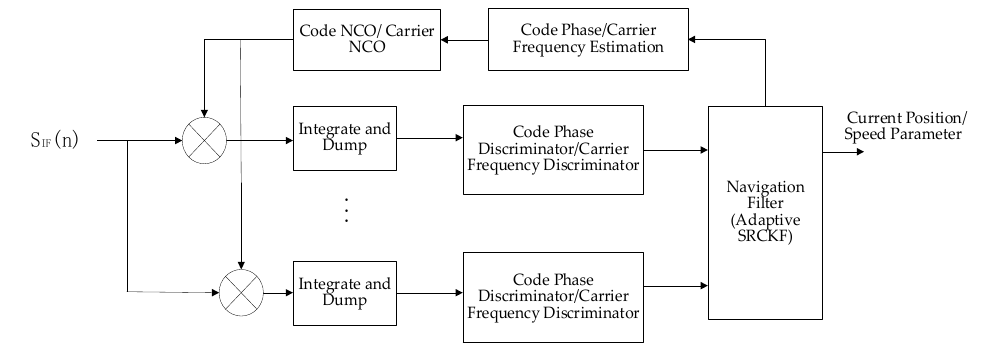
Figure 1. Vector tracking loop structure block diagram.